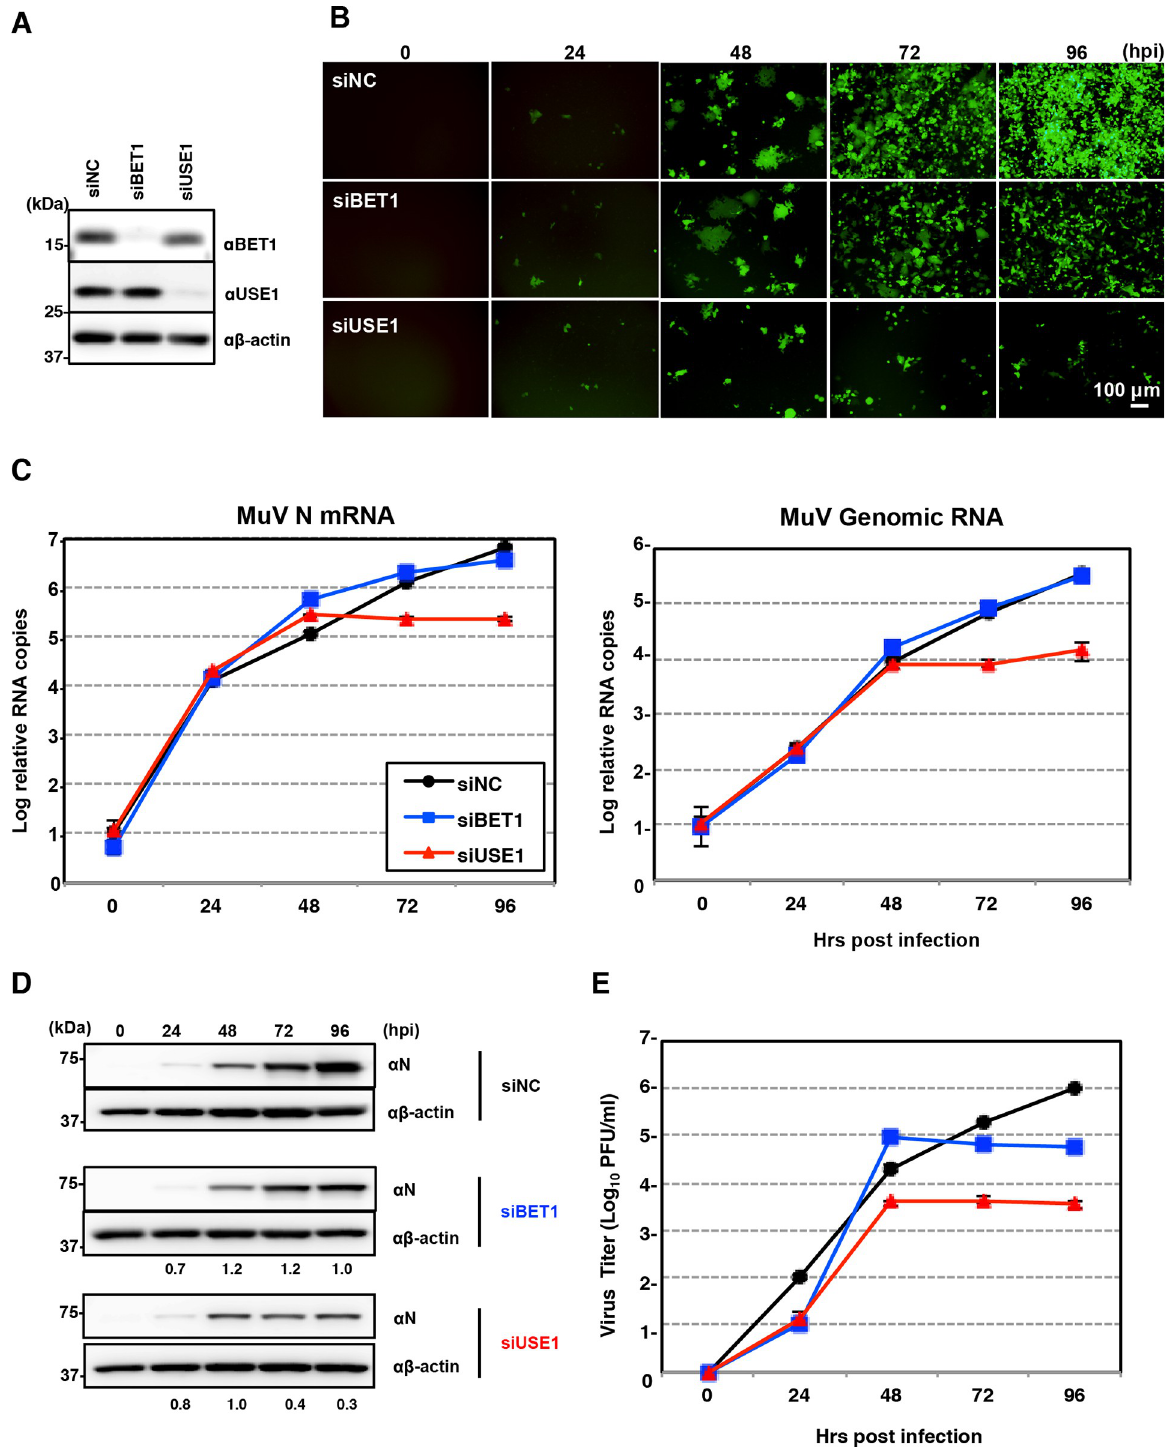
Fig 5. Importance of BET1 and USE1 for MuV propagation. (A) Immunoblotting showing the expression levels of BET1, USE1, and β -actin in A549 cells transfected with siBET1, siUSE1, or siNC. (B) Immunofluorescence of rOdate/AcGFP-infected A549 cells transfected with siBET1, siUSE1, or siNC at the indicated times. (C) Relative expressions of viral mRNA and genomic RNA in A549 cells transfected with siBET1 (blue line), siUSE1 (red line), or siNC (black line). (D) Immunoblotting showing the expression levels of MuV N protein and β -actin in A549 cells transfected with siBET1, siUSE1, or siNC. The relative band intensities of MuV N protein in A549 cells transfected with siBET1 or siUSE1 were